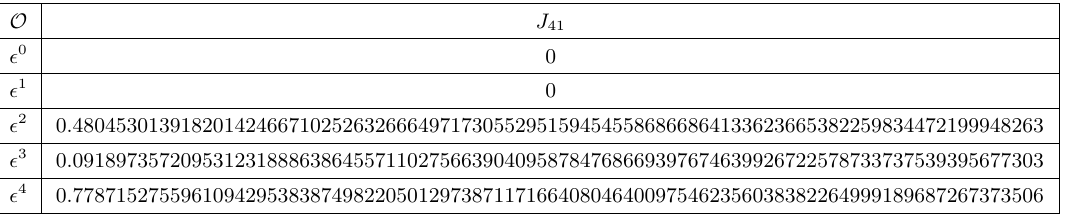
Table 2 . Numerical values of J 41 evaluated at ( x, y, z ) = (0.5, 0.5, 0.5) for first five orders of (cid:15) using analytic